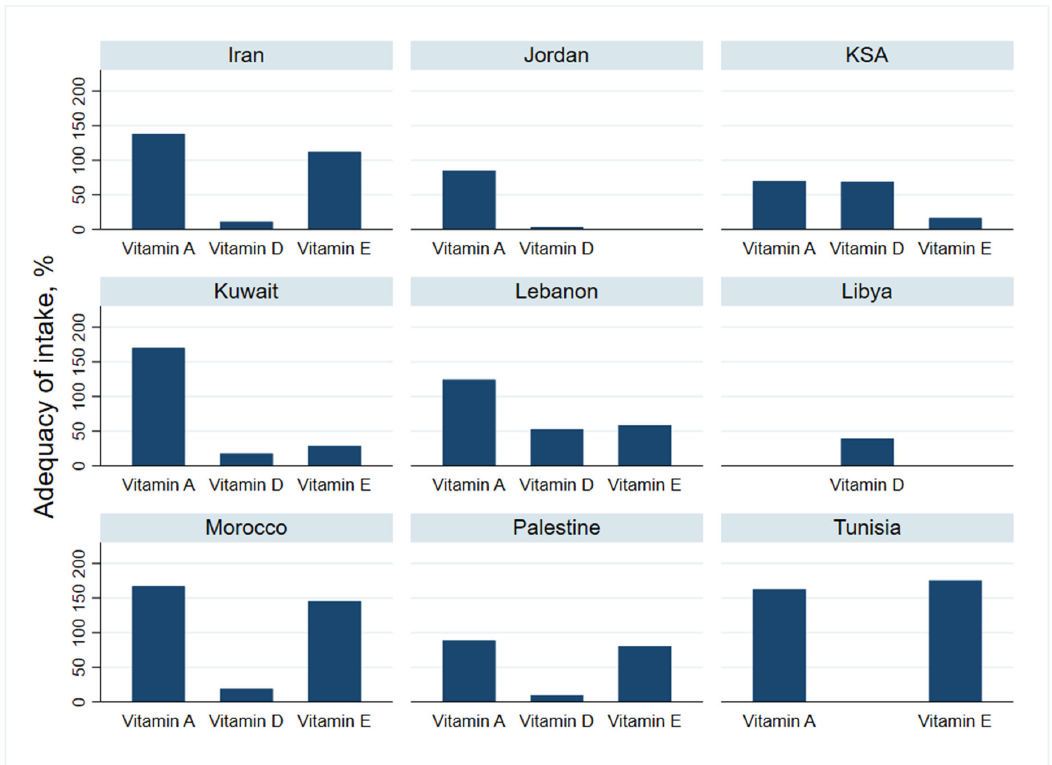
Figure 4. Adequacy of liposoluble vitamins intake for people in the countries sampled in the Eastern Mediterranean Re ‐ gion.